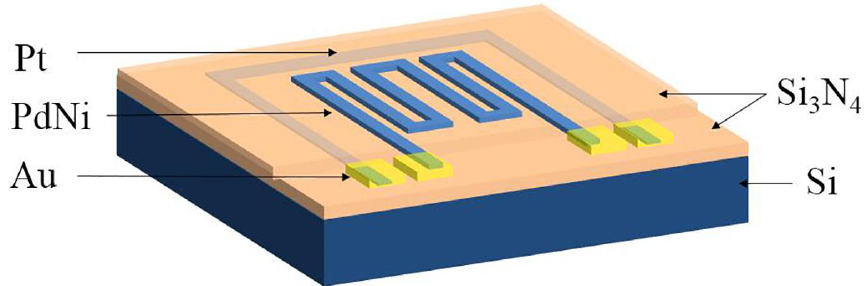
Figure 1. Schematic diagram of the hydrogen sensors.